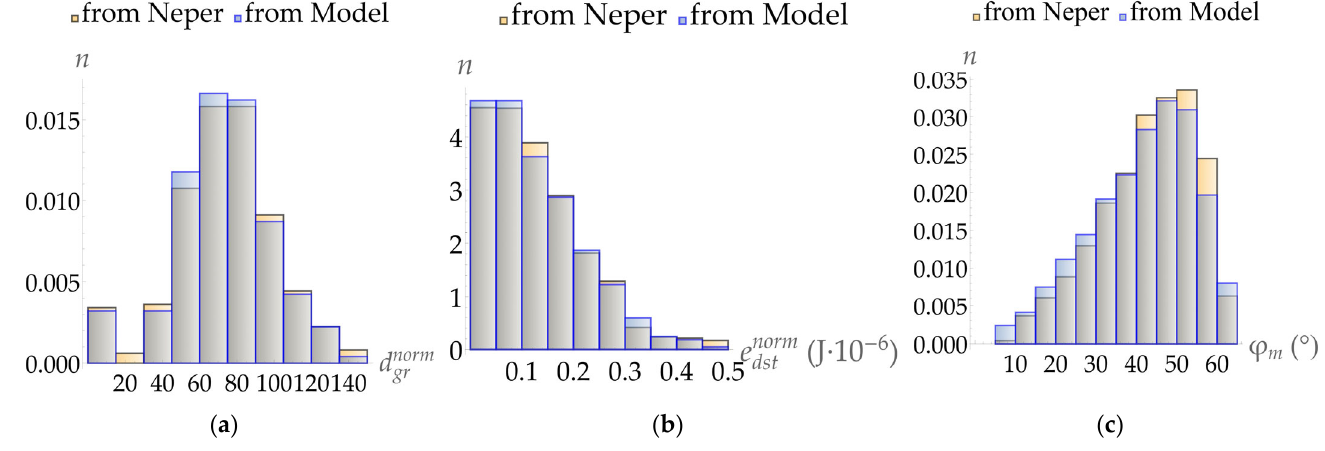
norm norm e and d and ˆ norm d , ( b ) and ˆ d norm gr , ( b ) e norm and ˆ e norm , 0 dst 0 gr gr gr 0 dst 0 dst